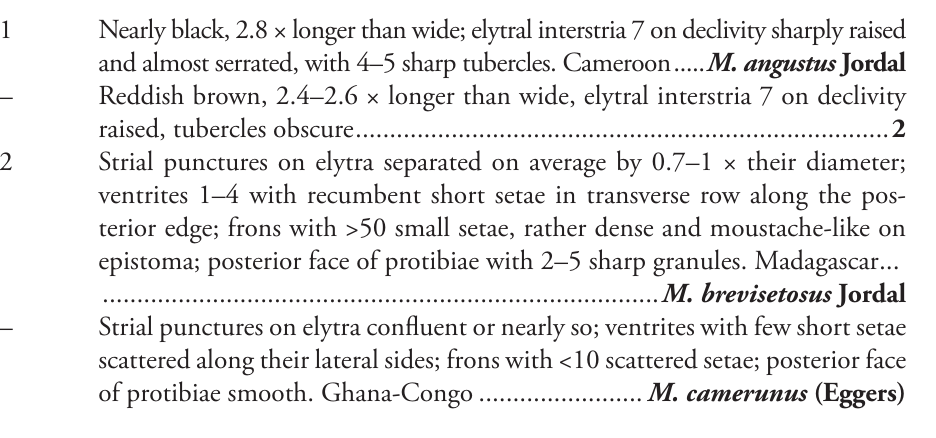
Key to the Afrotropical species of Microborus 1 Nearly black, 2.8 × longer than wide; elytral interstria 7 on declivity sharply raised and almost serrated, with 4–5 sharp tubercles. Cameroon ..... M. angustus Jordal – Reddish brown, 2.4–2.6 × longer than wide, elytral interstria 7 on declivity raised, tubercles obscure .............................................................................. 2 2 Strial punctures on elytra separated on average by 0.7–1 × their diameter; ventrites 1–4 with recumbent short setae in transverse row along the pos- terior edge; frons with >50 small setae, rather dense and moustache-like on epistoma; posterior face of protibiae with 2–5 sharp granules. Madagascar ... ................................................................................. M. brevisetosus Jordal – Strial punctures on elytra confluent or nearly so; ventrites with few short setae scattered along their lateral sides; frons with <10 scattered setae; posterior face of protibiae smooth. Ghana-Congo ........................ M. camerunus